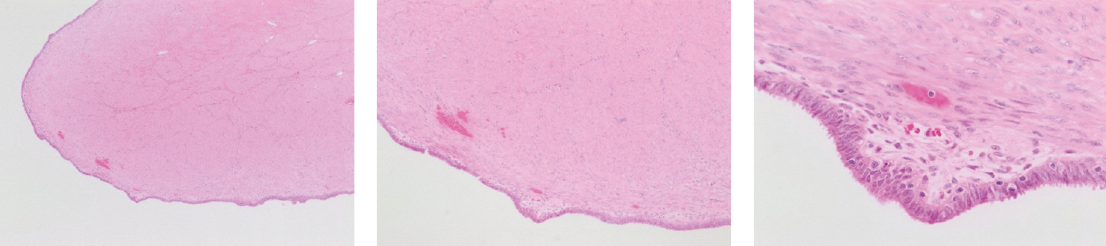
Figure 2: Immunohistochemical analysis staining with H&E at 100x, 200x, and 400x displaying epithelial cells and underlying stromal